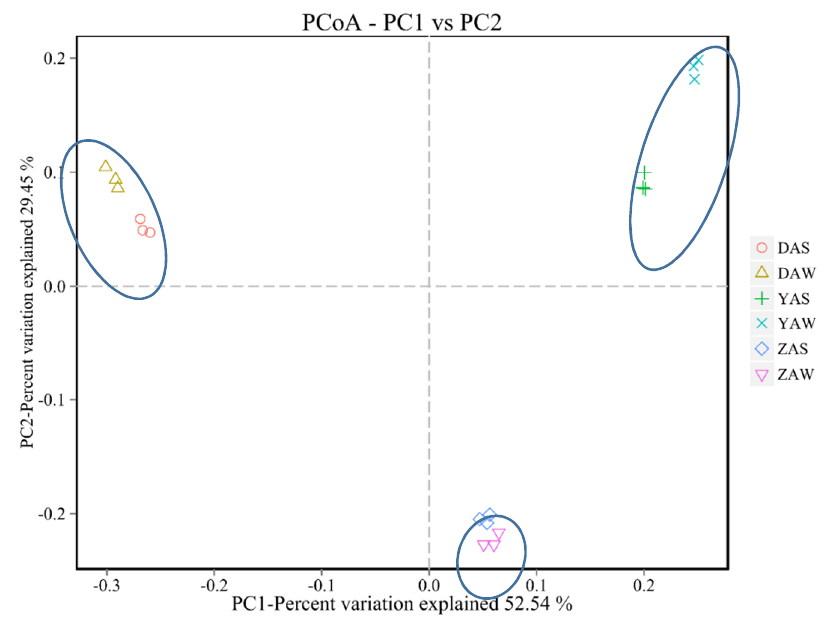
Figure 2. Principal coordinates analysis based on the operational taxonomic unit abundance in microbial communities of different sludge samples.